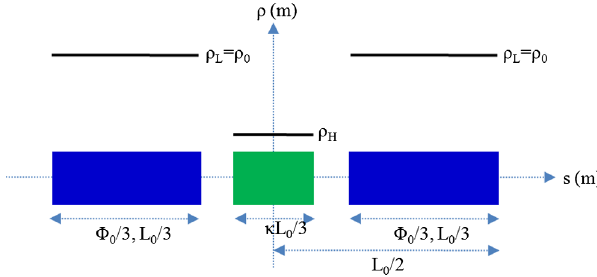
FIG. 14. The central low field dipole is split on three bending sections. The middle section (green color) is the high field inserted dipole which is sandwiched between two low field dipoles (blue color). The κ factor can vary from 0 to 1.